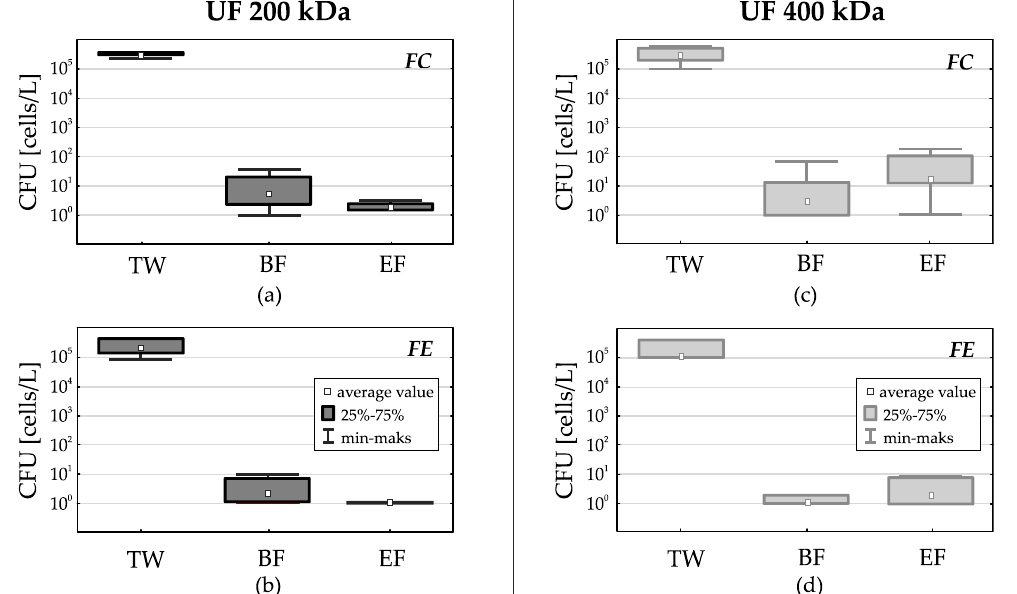
Figure 4. Comparison of the indicator bacteria number in treated wastewater (TW) subjected to membrane filtration with the use of ultrafiltration membranes with separation of 200 kDa and 400 kDa at the beginning of the filtration cycle (BF) and at the end of the filtration cycle (EF); ( a )—FC, 200 kDa; ( b )—FE, 200 kDa; ( c )—FC, 400 kDa; ( d )—FE, 400